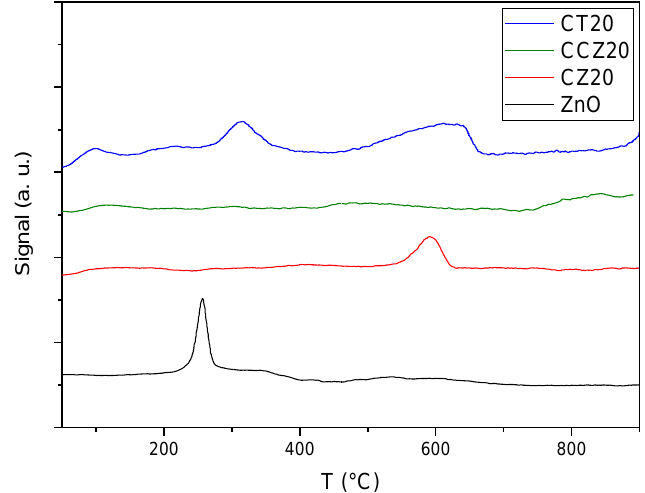
Figure 9. He-TPD of Ce-Zn composite.